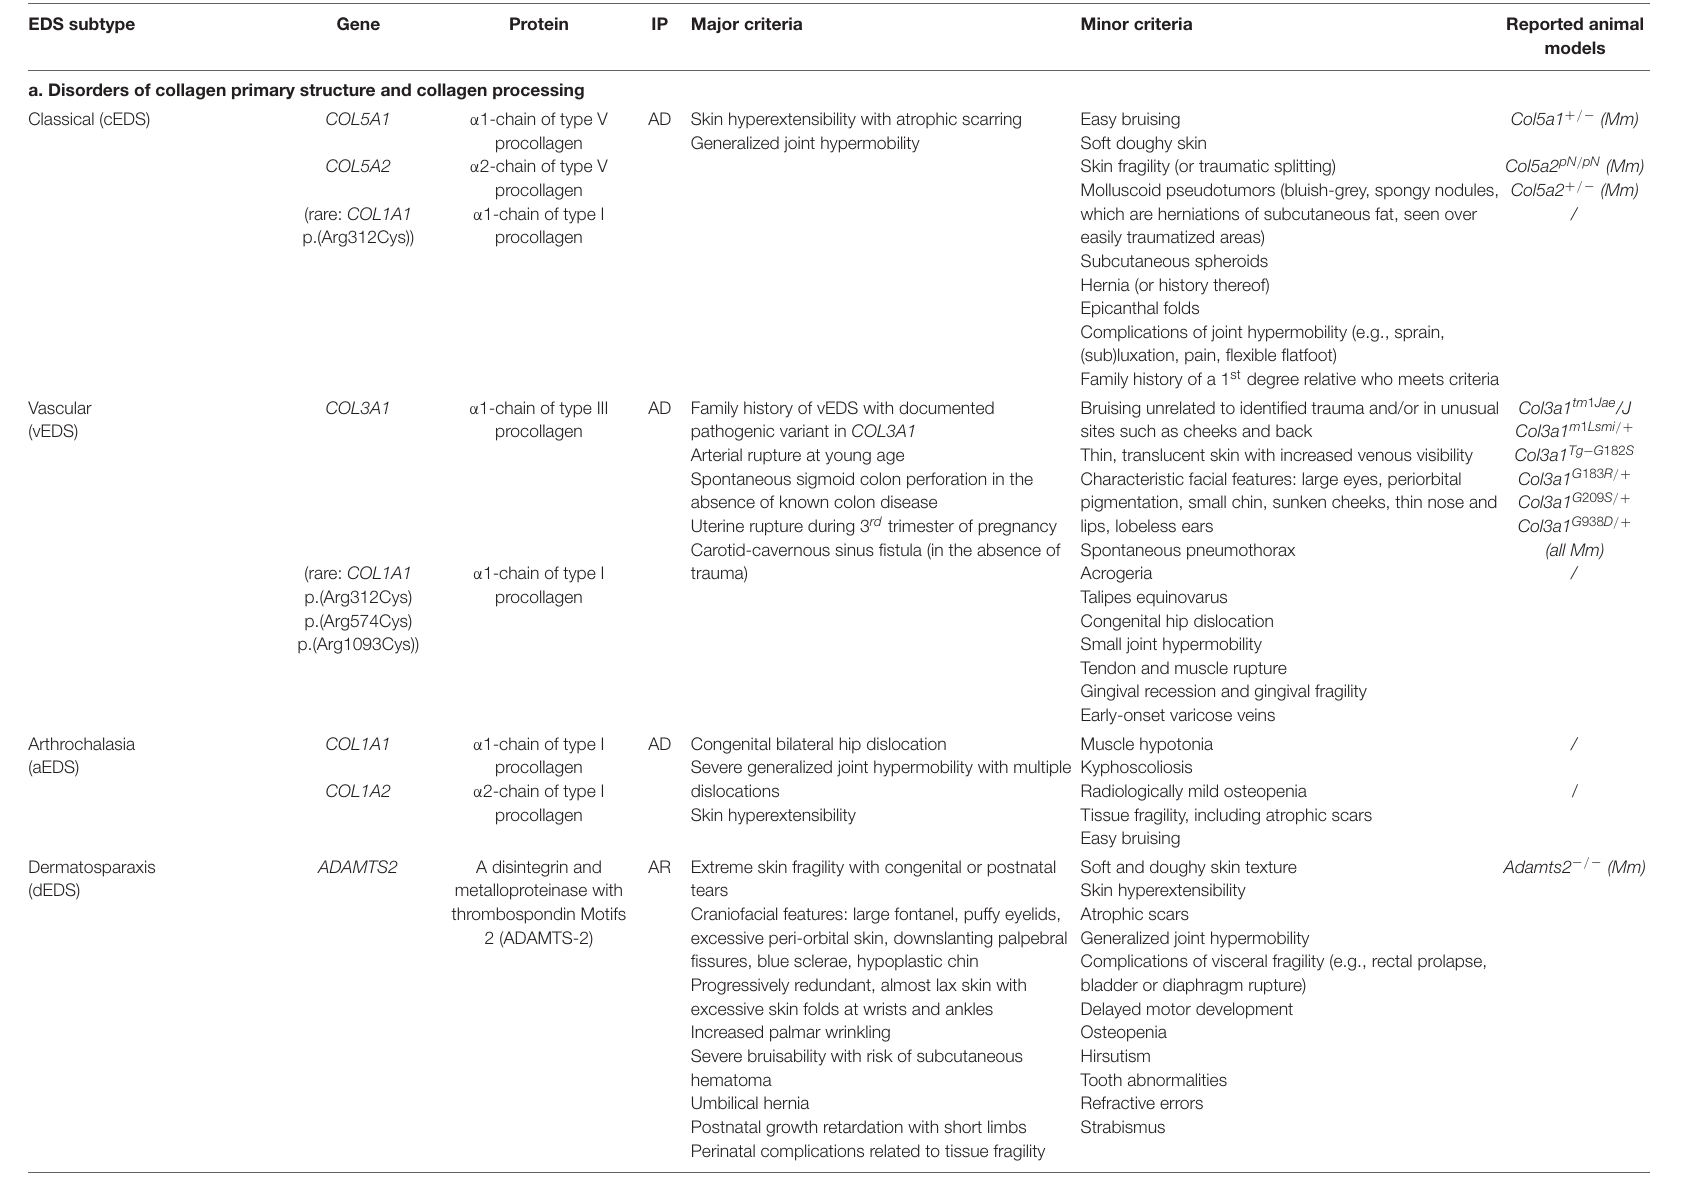
TABLE 1 | Overview of the Ehlers-Danlos syndrome (EDS) types, causal gene and protein, inheritance pattern (IP) and the major and minor clinical criteria as defined by the 2017 International EDS Classification with the reported animal models indicated. EDS